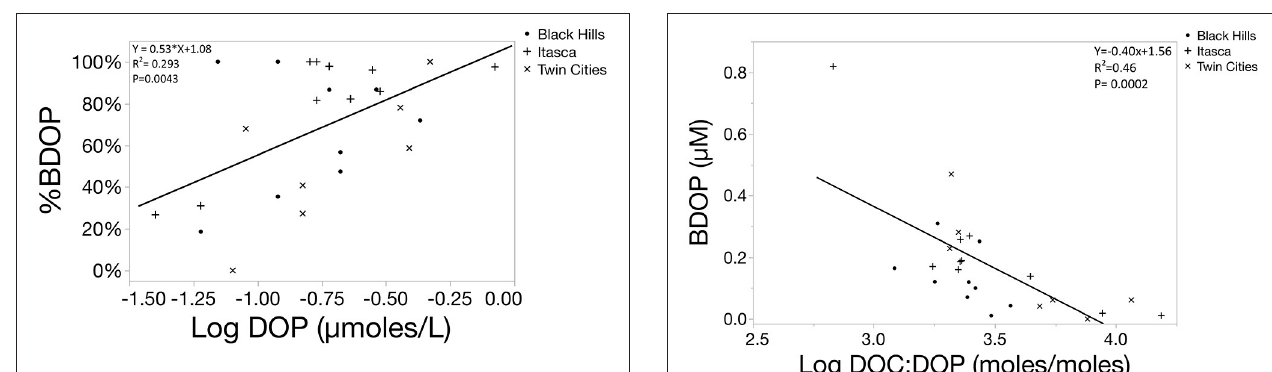
FIGURE 6 | Scatterplot showing the linear regression between the %BDOP and the original concentration of DOP in the sample (log transformed) for 26 lakes. One lake had to be excluded because the initial SRP concentration was below the method detection limit, so a DOP concentration could not be calculated. A positive relationship shows that as DOP concentration increased among systems, the relative lability of DOP increased.